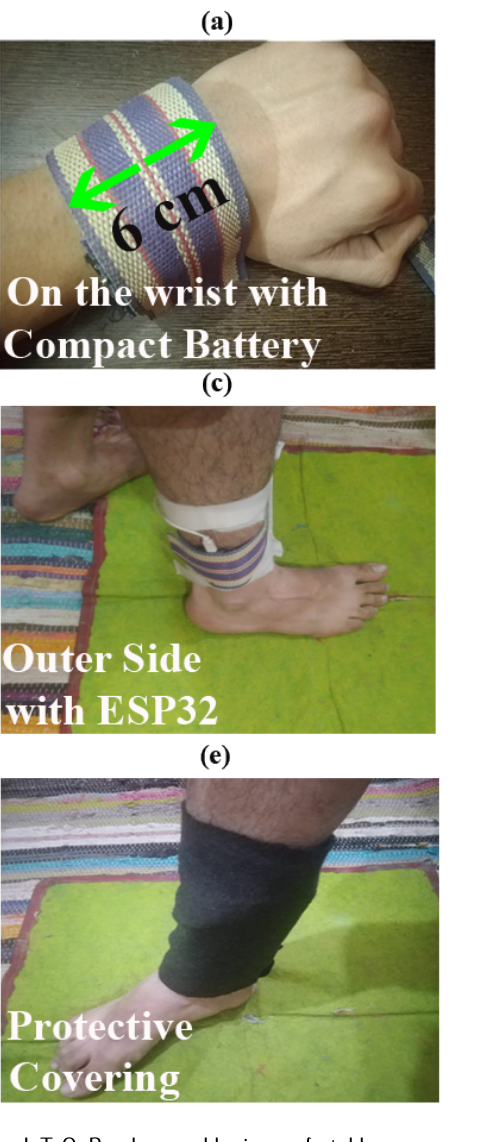
Figure 4. The IoT-Q-Band wearable is comfortably worn over the wrist or leg with firm fitting. (a) Depicts a user wearing the IoT-Q-Band over the wrist. (b) and (c) shows the inner and outer side of the wearable when worn over the legs. (d) shows the battery pouch, whereas (e) shows the protective covering over the IoT-Q-Band so that the band does not hinder the normal walking. (f) shows that even a trouser could be easily worn over the